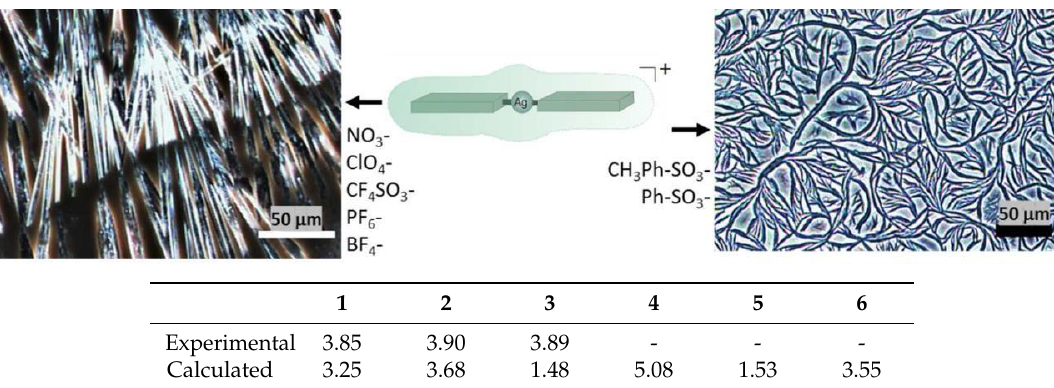
Table 2. Experimental and calculated band gap energies (eV) of Ag complexes 1 – 6 .